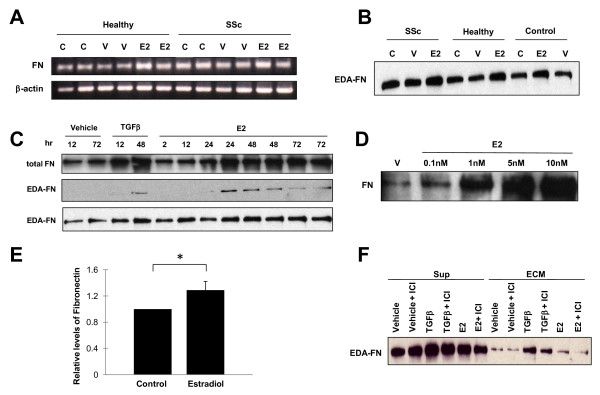
Estradiol increases fibronectin production in vitro. (A) Fibronectin (FN) mRNA expression in primary skin fibroblasts from twins discordant for systemic sclerosis (SSc). FN mRNA was analyzed after 24-hour treatment with 10 nM 17β-estradiol (E2), vehicle (V), or no treatment (control, C) using RT-PCR. Assays were done in duplicate. (B) FN protein expression in culture supernatants of primary skin fibroblasts. FN protein expression was analyzed by western blot in untreated, E2-treated or vehicle-treated fibroblasts for 48 hours. SSc, SSc patient; healthy, healthy twin of an SSc patient; control, unrelated healthy donor. (C) FN protein expression in the extracellular matrix (ECM) and culture supernatants (Sup) of normal skin fibroblasts treated with vehicle, transforming growth factor beta (TGFβ), or E2. ECM and culture supernatants were harvested at the indicated time points. (D) FN levels in the ECM and Sup of normal skin fibroblasts stimulated with vehicle and different concentrations of E2 ranging from 0.1 to 10 nM. (E) Graphical summary of FN levels representing data from four independent experiments. *P = 0.0036. (F) Effect of E2 blockade on the expression of FN protein in the ECM and Sup of normal skin fibroblasts stimulated with E2. Cells were treated with E2 for 48 hours in the presence or absence of the ER antagonist ICI 182,780.